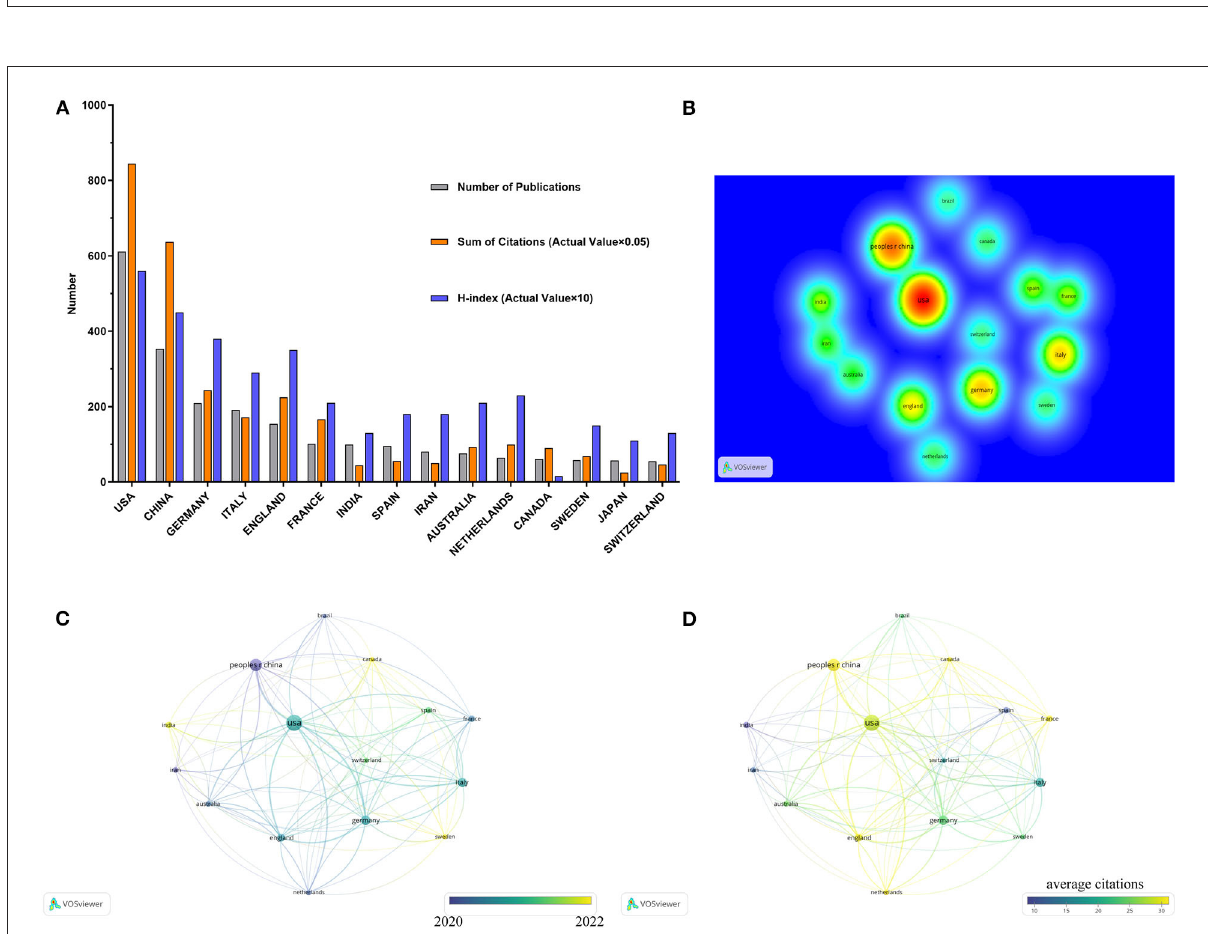
FIGURE2 Publication of articles in various countries/regions. (A) The total number of citations ( × 0.05) and H-index ( × 10) of articles from the top 15 countries ranked by publications’ number. (B) Density map of the top 15 countries ranked by number of publications. (C) International cooperation among top 15 countries. (D) The top 15 countries were shown in chronological order of